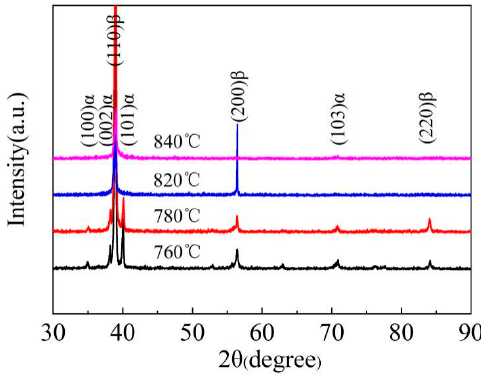
ff raction spectra of specimens after di ff erent solution Figure 4. X-ray diffraction spectra of specimens after different solution treatments. Figure 4. X-ray di